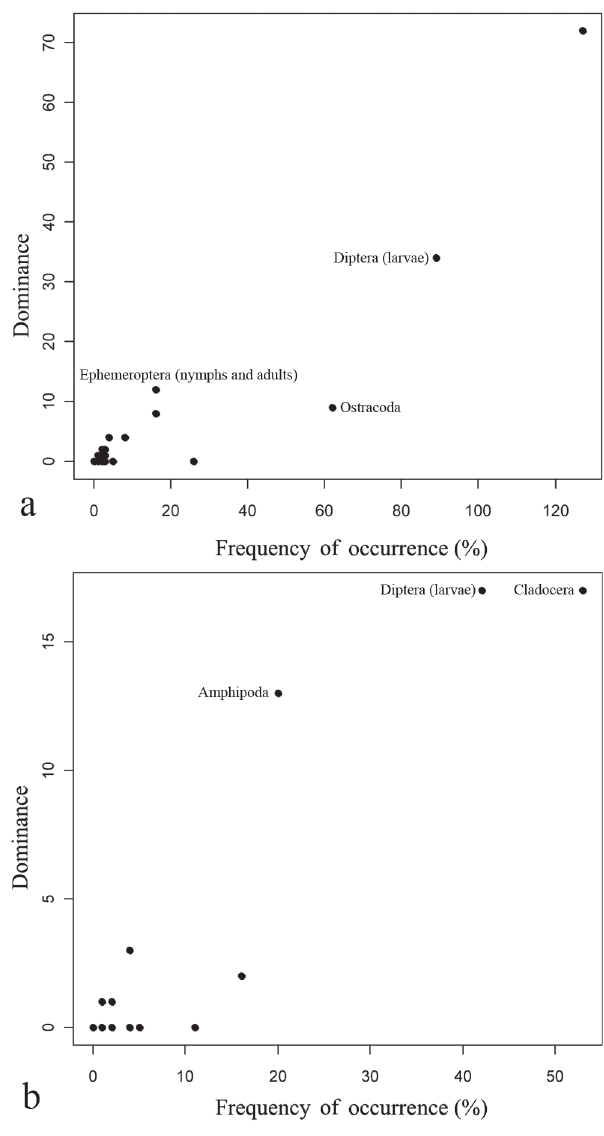
Fig. 3. Diet of males ( a ) and females ( b ) of Cynopoecilus melanotaenia from wetlands between São Gonçalo channel and Pelotas stream, during May and June 2005, and September 2006, according to the frequency of occurrence and dominance of food items.